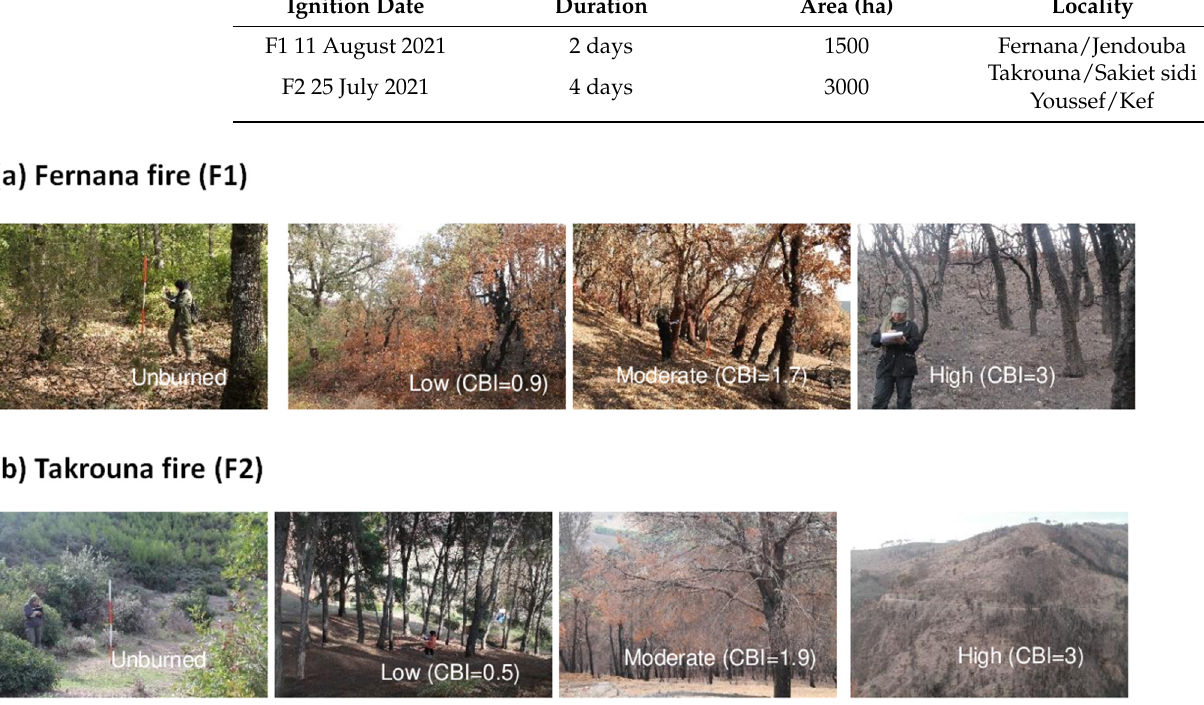
Figure 2. Field photos showing the different levels of severity assigned in the Fernana ( a ) and Takrouna fires ( b ).